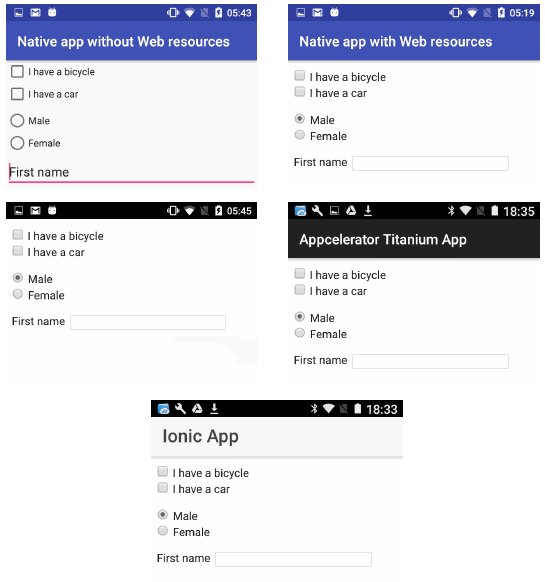
Fig. 8. Components ”radio button”, ”checkbox” and ”text field” implemented in the native application (without Web resources), native application (with Web resources), Cordova, Appcelerator application and Ionic application,